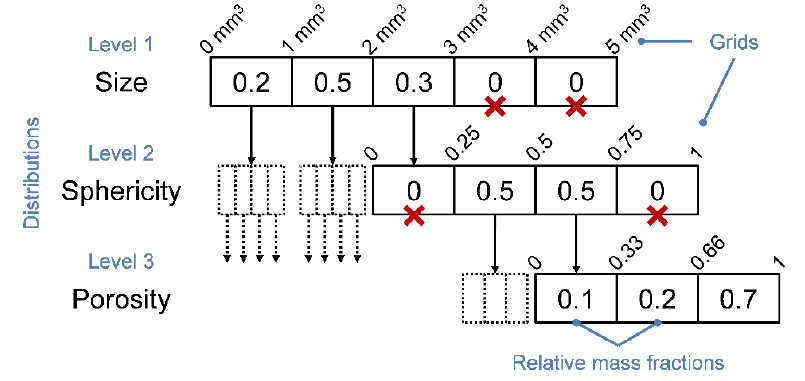
Figure 2. Tree data structure for storing interdependent multidimensional distributed parameters of solids in Dyssol.